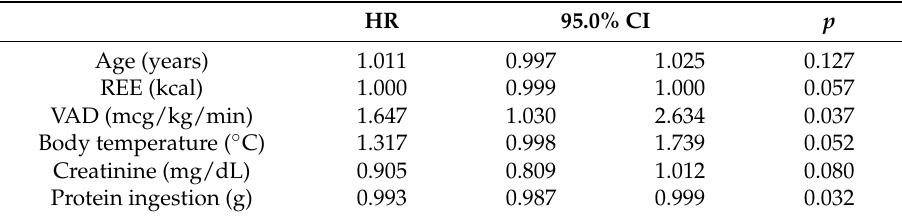
Table 6. Cox regression analysis for association with death.